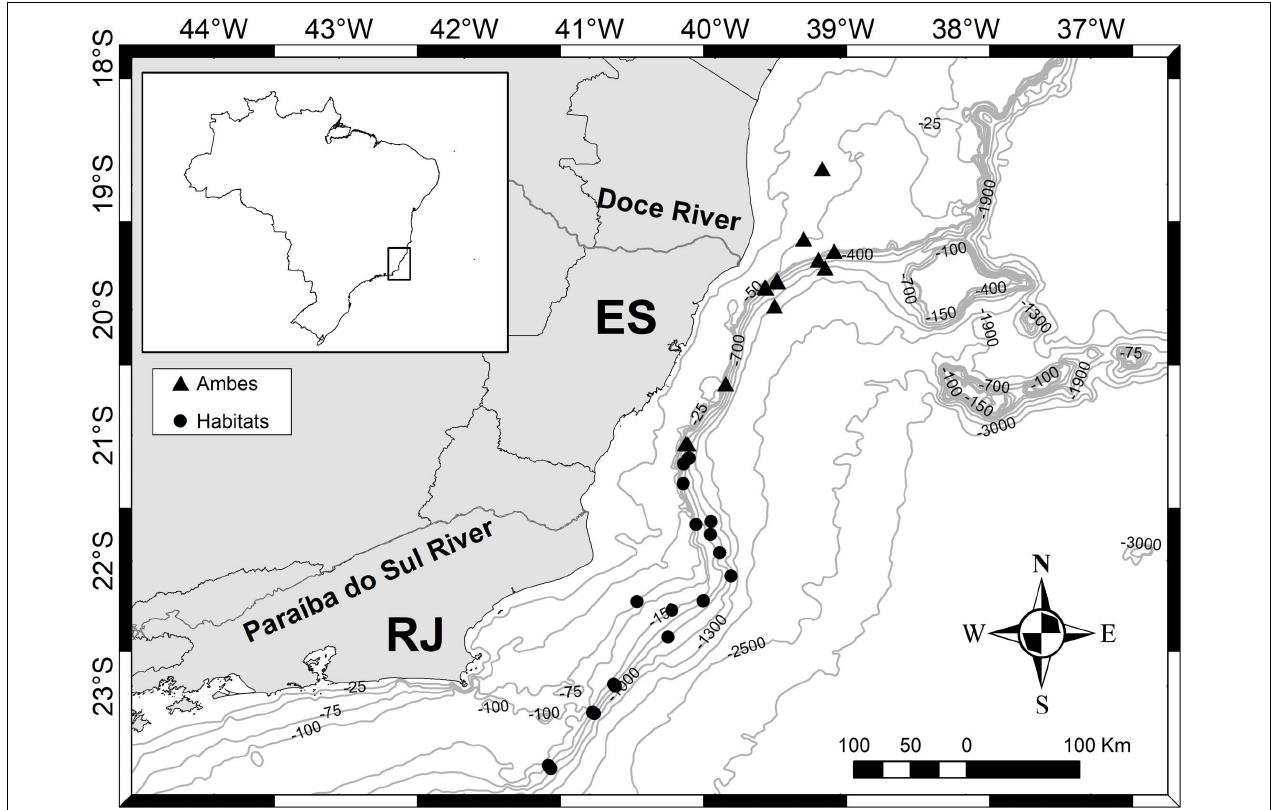
FIGURE 5 | Scutopus variabilis sp. nov. Sampling area of the “Habitats” (off Rio de Janeiro) and “Ambes” (off Espírito Santo) Projects showing the bathymetric distribution in the area of the Espírito Santo and Rio de Janeiro